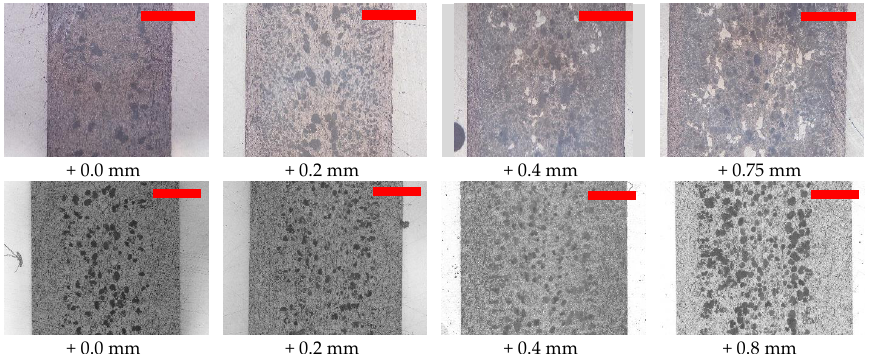
Figure 11. Foam structure of physically ( top row ; N06_T60) and chemically ( bottom row ; CB_film) foamed specimens of PPCell at different mould opening gaps. Dark spots in the samples represent pores, i.e., voids. Bright spots represent pores filled with resin from the sample preparation. The red bars represent 1 mm.